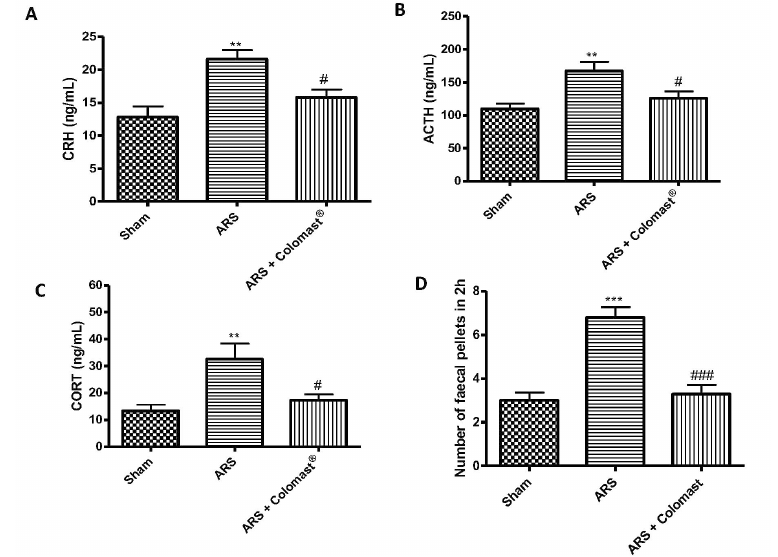
Figure 1. Effect of Colomast ® pre-treatment on stress hormones and fecal output. Elisa kit of hypothalamic corticotrophin-releasing hormone (CRH) ( A ), adrenocorticotrophic hormone (ACTH) ( B ), and corticosterone (CORT) ( C ) expressed in plasma. Fecal pellet outputs ( D ). Values shown are means ± SEM of six animals in each group. ** p < 0.01 vs. sham; *** p < 0.001 vs. sham; # p < 0.05 vs. ARS group; ### p < 0.001 vs. ARS group.